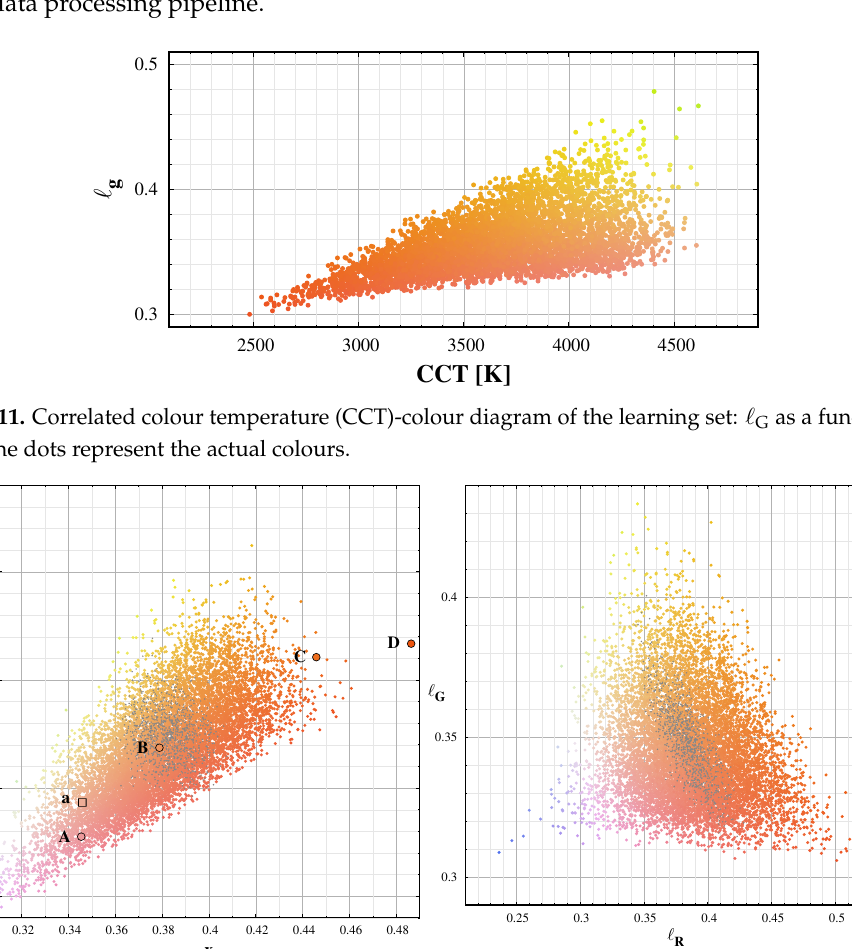
Figure 12. Colour-colour diagrams for an extended dataset. Left: CIE x-y colours, Right: (cid:96) R − (cid:96) G colour space. The dots represent the actual colours; grey dots: natural spectra